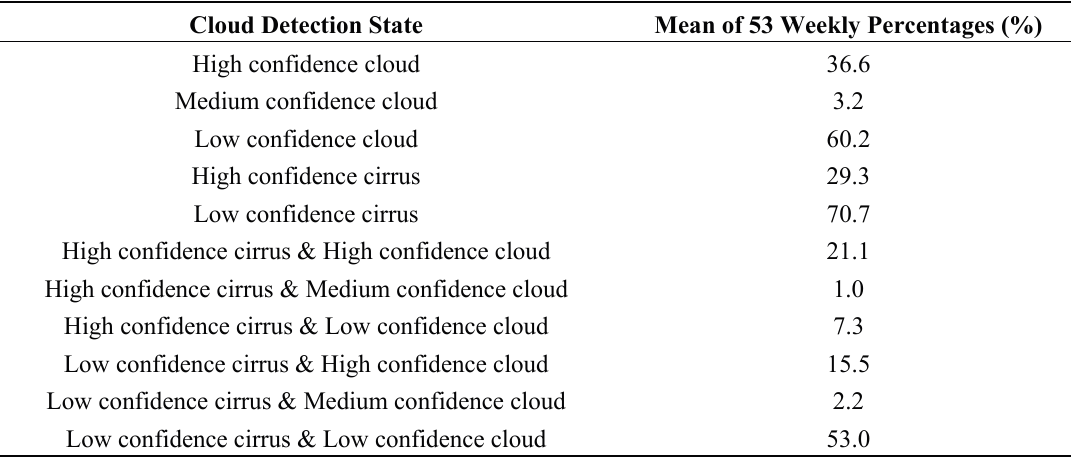
Table 1. Mean weekly percentages of cloud and cirrus detection states for 53 weeks of Landsat 8 conterminous US (CONUS) data. The “&” denotes coincident detection of two cloud states at a pixel location. The High confidence cloud, High confidence cirrus, and High confidence cirrus & Low confidence cloud values reflect the means of the three data sets illustrated in Figure 1. The percentages for each exhaustive set of cloud states may not sum to 100% as CONUS mean values are